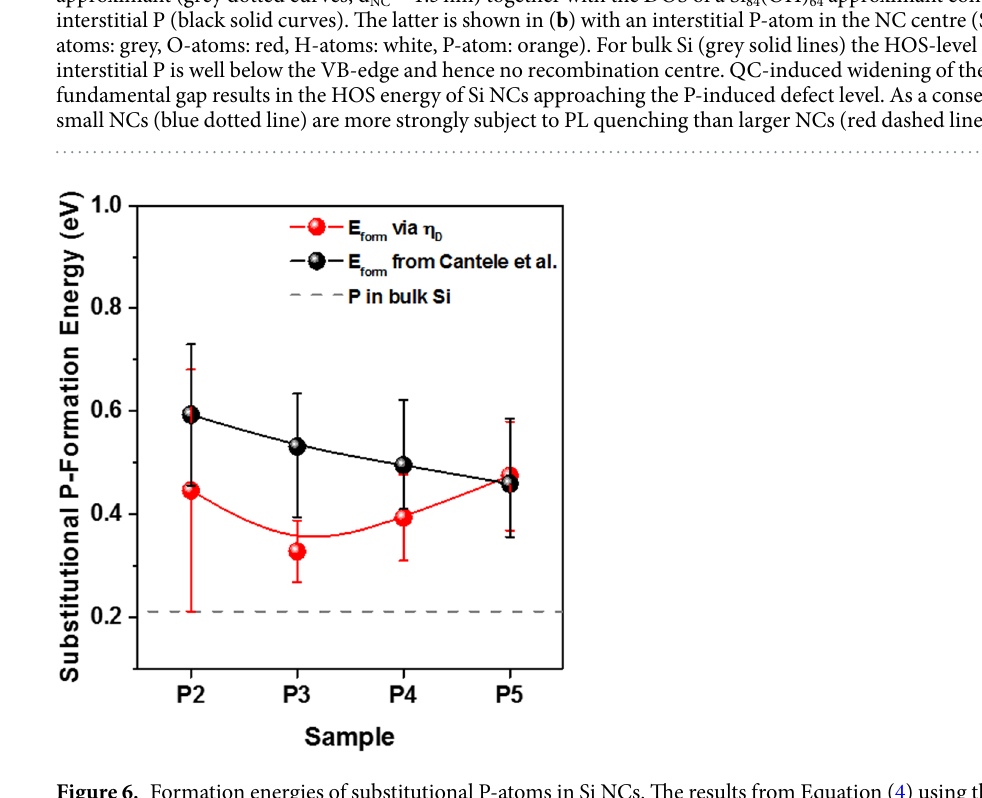
formation energy in bulk Si. For comparison, we also plot in Fig. 6 (black symbols) the theoretically calculated formation energies for P-atoms on Si-lattice site positions presented in ref. 44. The experimental values range mainly at the lower end of the error bars of the theoretical values, though it has to be mentioned that Cantele et al . 44 only considered very small (0.52–1.12 nm radius) and approximants with full H-termination. Irrespective of the experimental errors and the different theoretically studied sample system, Si NCs have significantly higher sub- stitutional P-formation energies as compared to bulk-Si. Accordingly, only a small percentage of all incorporated P-atoms resides on Si lattice sites where they can become donors by field emission, leaving the vast majority of P-atoms on interstitial sites. As discussed before, the trend of decreasing E form for samples P5 to P3 might originate